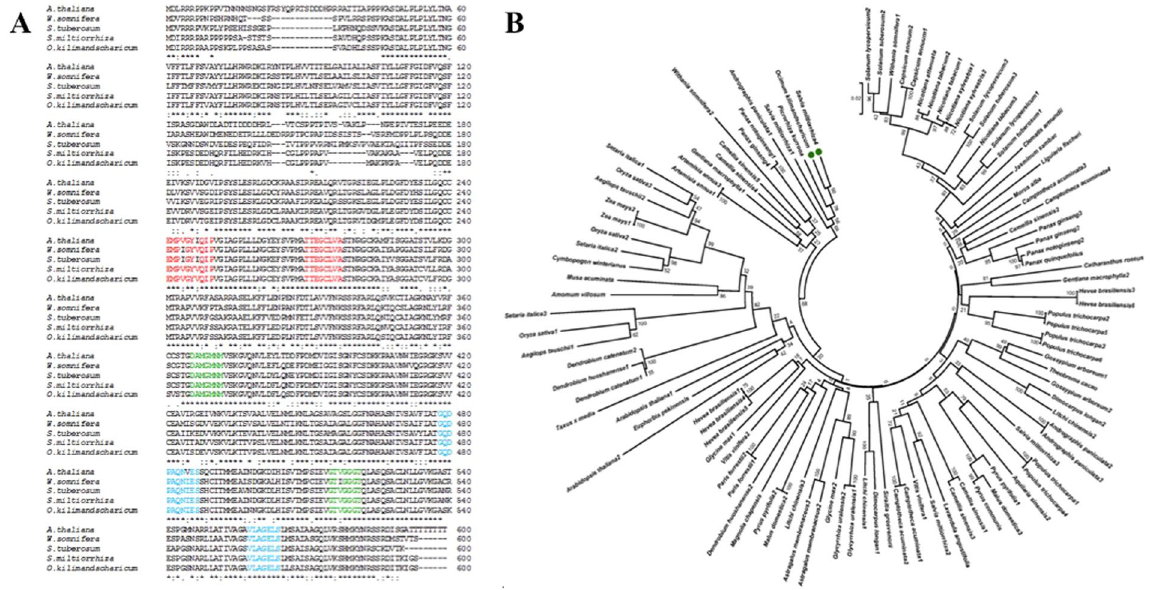
Figure 2. Multiple sequence alignment and phylogenetic analysis of OkHMGR. ( A ) Multiple sequence alignment of OkHMGR and visualization of different motifs. Three sets of motifs, each having two motifs were detected. NADP(H) binding motifs (green), HMG-CoA binding motifs (red), and plant specific motifs(blue). The consensus sequences of NADPH binding motif are [DAMGMNM] & [GTVGGGT], HMG-CoA binding motifs are [EMPVGYVQIP] & [TTEGCLVA] and plant specific motifs are [GQDPAQN] & [VLAGELS] ( B ) Phylogenetic analysis of 108 plant HMGRs from 55 different species analysed by neighbor joining approach, with 1000 bootstrap